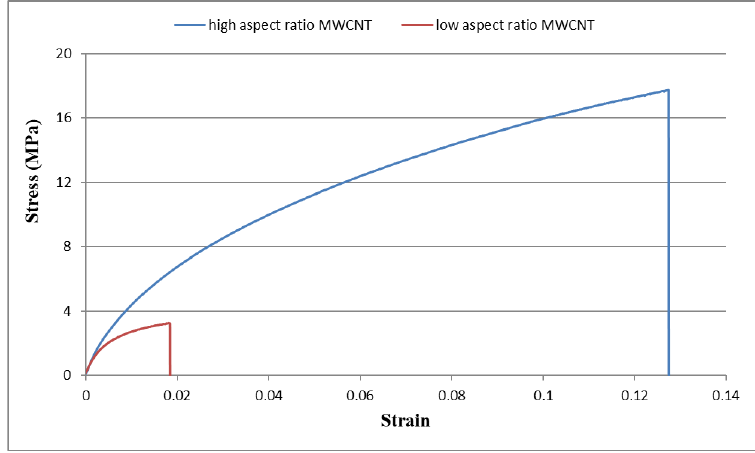
Table 1. Tensile properties of buckypapers composed of high aspect ratio MWCNTs and low aspect ratio MWCNTs.